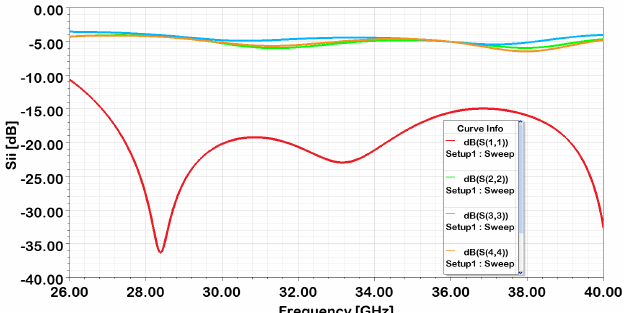
FIGURE 11. Matching on all the four ports of the system without QWT.